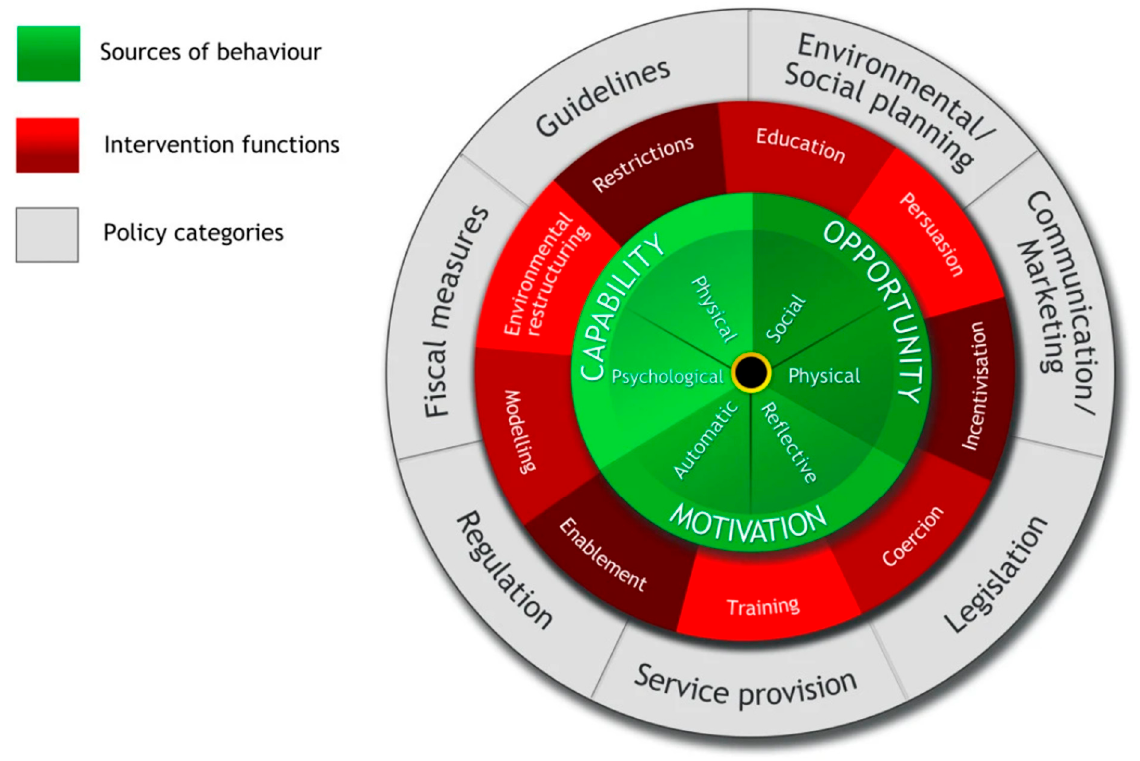
Figure 2. The Behaviour Change Wheel